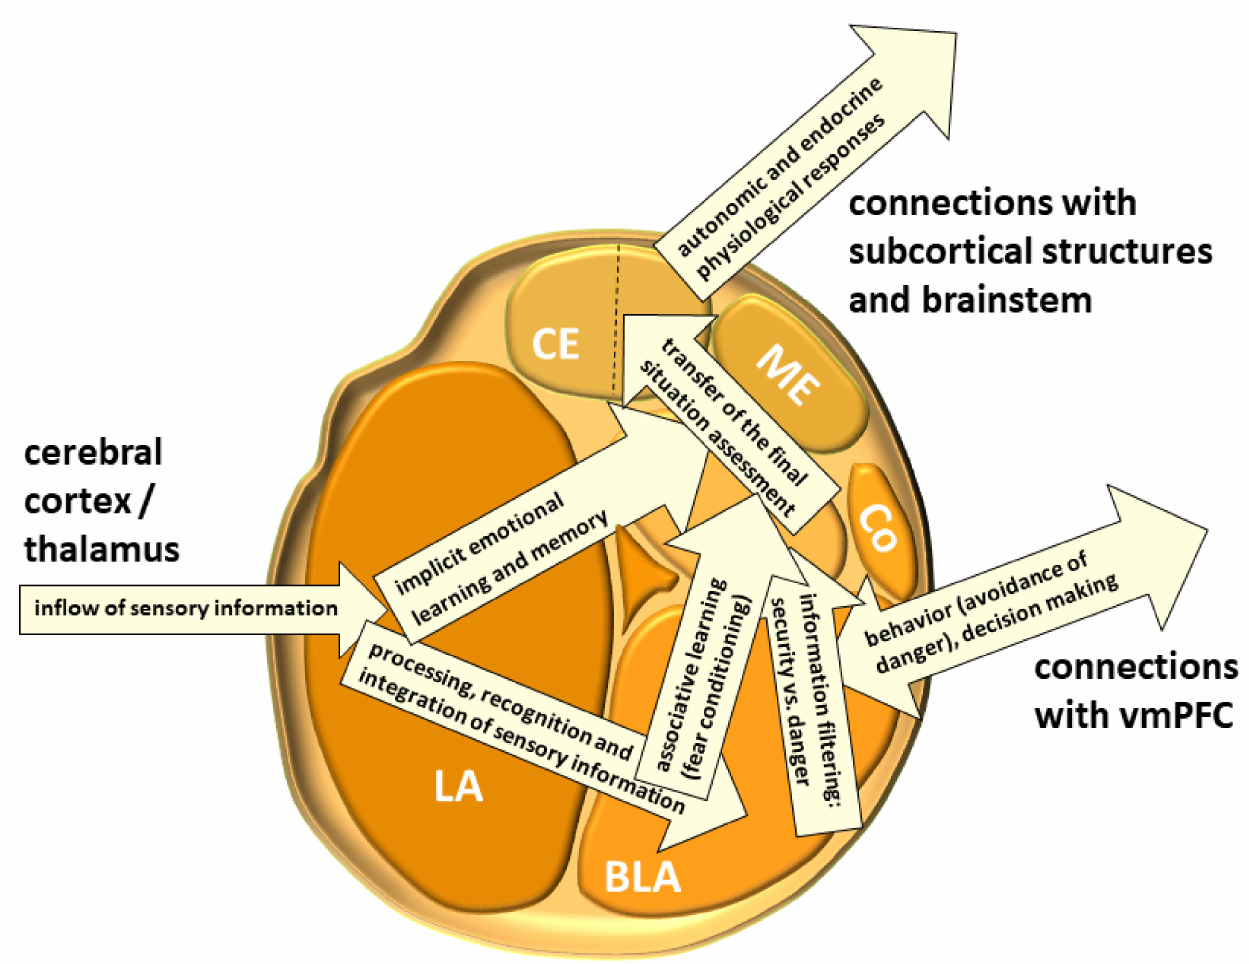
Figure 10. Simplified representation of the information flow within the amygdala. BLA—basolateral nucleus of the amygdala; CE—central nucleus of the amygdala; Co—cortical nucleus of amygdala; LA—lateral nucleus of amygdala; ME—medial nucleus of amygdala; vmPFC—the ventromedial prefrontal cortex; BM—basomedial (accessory basal) nucleus of the amygdala. The schematics are made according to Sah et al., (2017) [108], Asami et al., (2018) [162], and Neugebauer (2020)